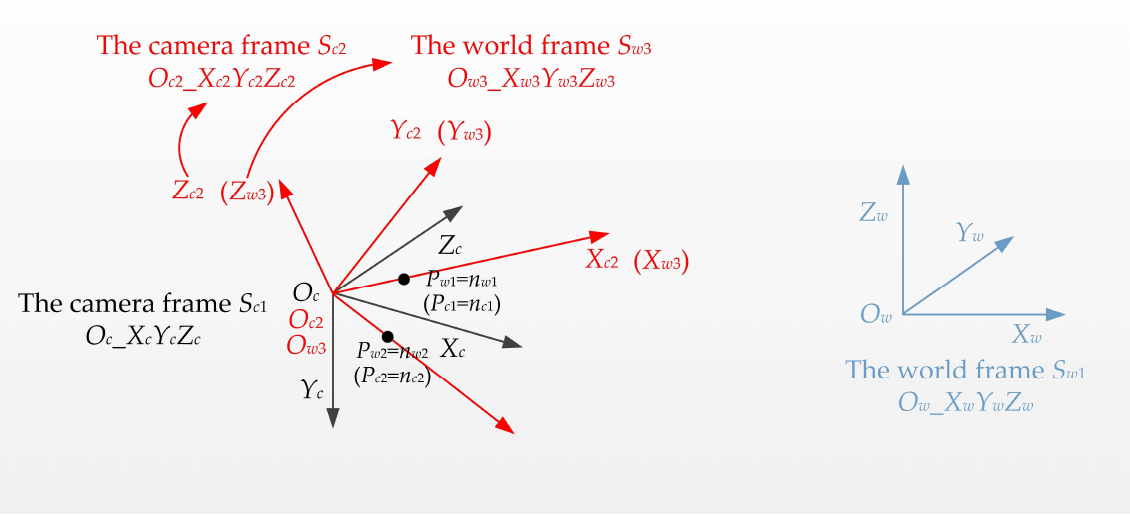
Figure 3. New camera frame and world frame plotted in red.